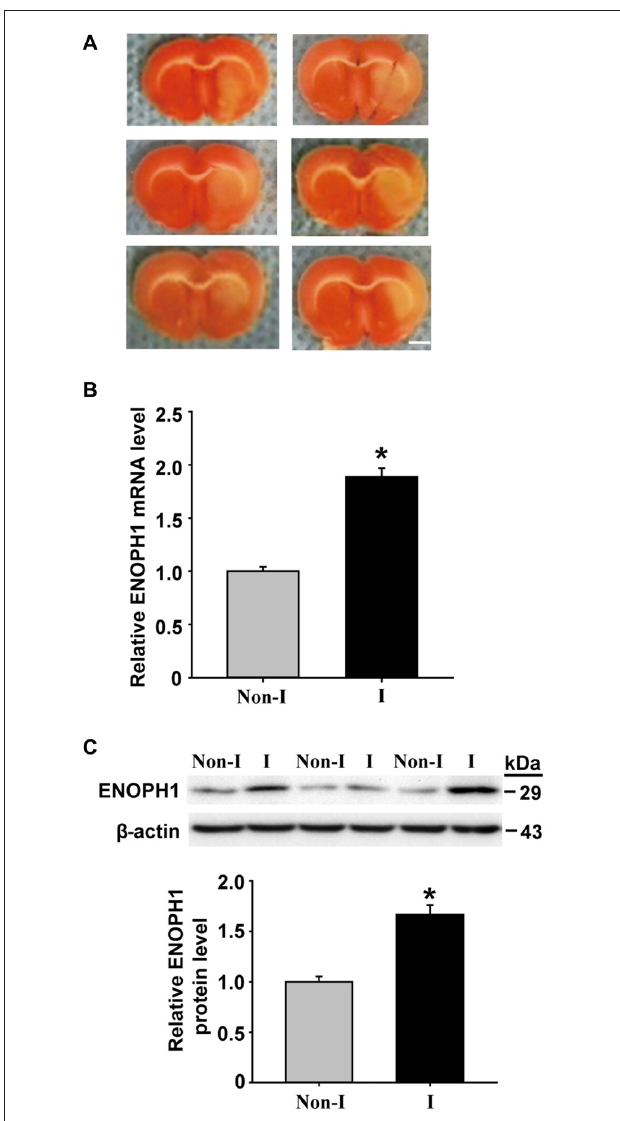
FIGURE 1 | Middle cerebral artery occlusion (MCAO) induces Enolase-phosphatase 1 (ENOPH1) upregulation in ischemic cerebral microvessels. Rats were subjected to 3 h MCAO before isolating hemispheric cerebral microvessels. The mRNA and protein levels of ENOPH1 in cerebral microvessels from nonischemic (Non-I) and ischemic (I) hemispheric tissue were analyzed by real-time RT-PCR and western blot. (A) Representative photographs of triphenyltetrazolium chloride (TTC) stained 1 mm-thick brain sections showing tissue infarction (pale white region) in the ischemic hemispheres (right). (B) Real-time RT-PCR analysis showed that ENOPH1 mRNA expression was significantly increased in ischemic hemispheric microvessels. ∗ P < 0.05 vs. Non-I; n = 6. (C) Western blot analysis revealed increased levels of ENOPH1 protein in ischemic hemispheric microvessels. Upper panel: representative immunoblots of ENOPH1 and the loading control β -actin; bottom panel: quantitative data of protein band intensity after normalization to β -actin. ∗ P < 0.05 vs. Non-I; n = 6.